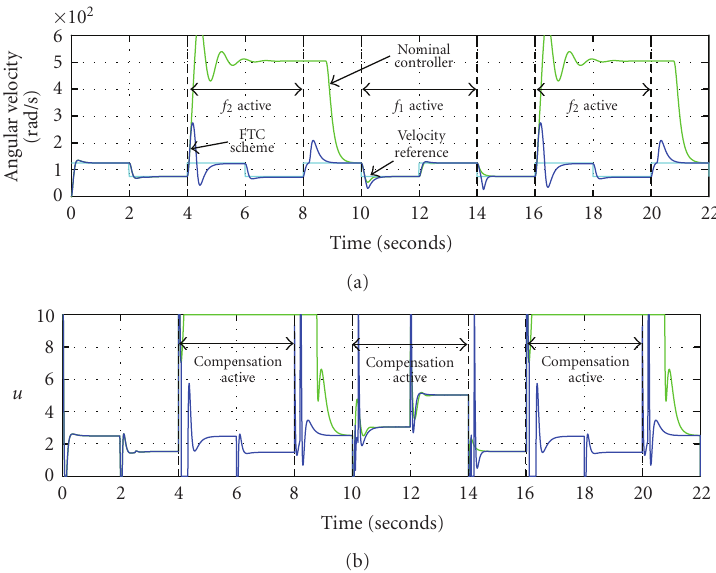
Figure 8: Simulation evaluation of FTC scheme: (a) angular velocity, and (b) control signal.